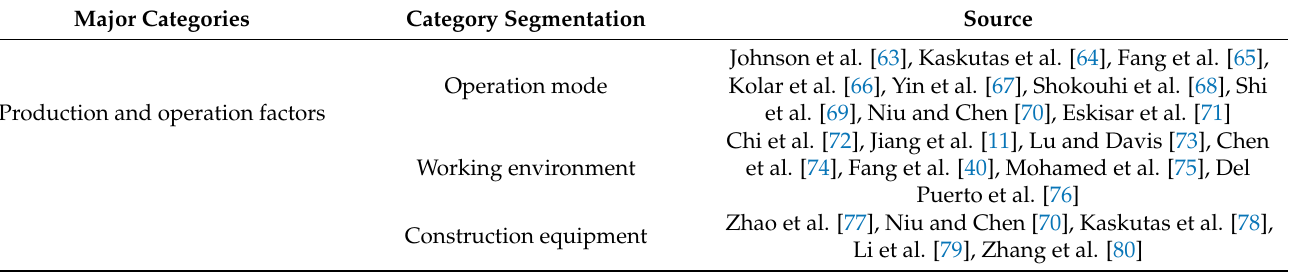
Table 5. Production and operation